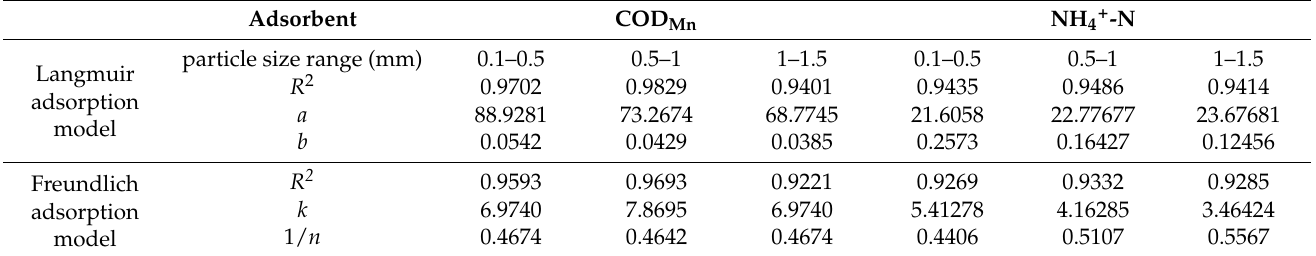
Figure 2. Adsorption isotherms of river sand with different particle sizes and pollutants. ( a ) COD Mn . ( b ) NH 4+ -N. Table 2. Adsorption model parameters of COD Mn and NH 4+